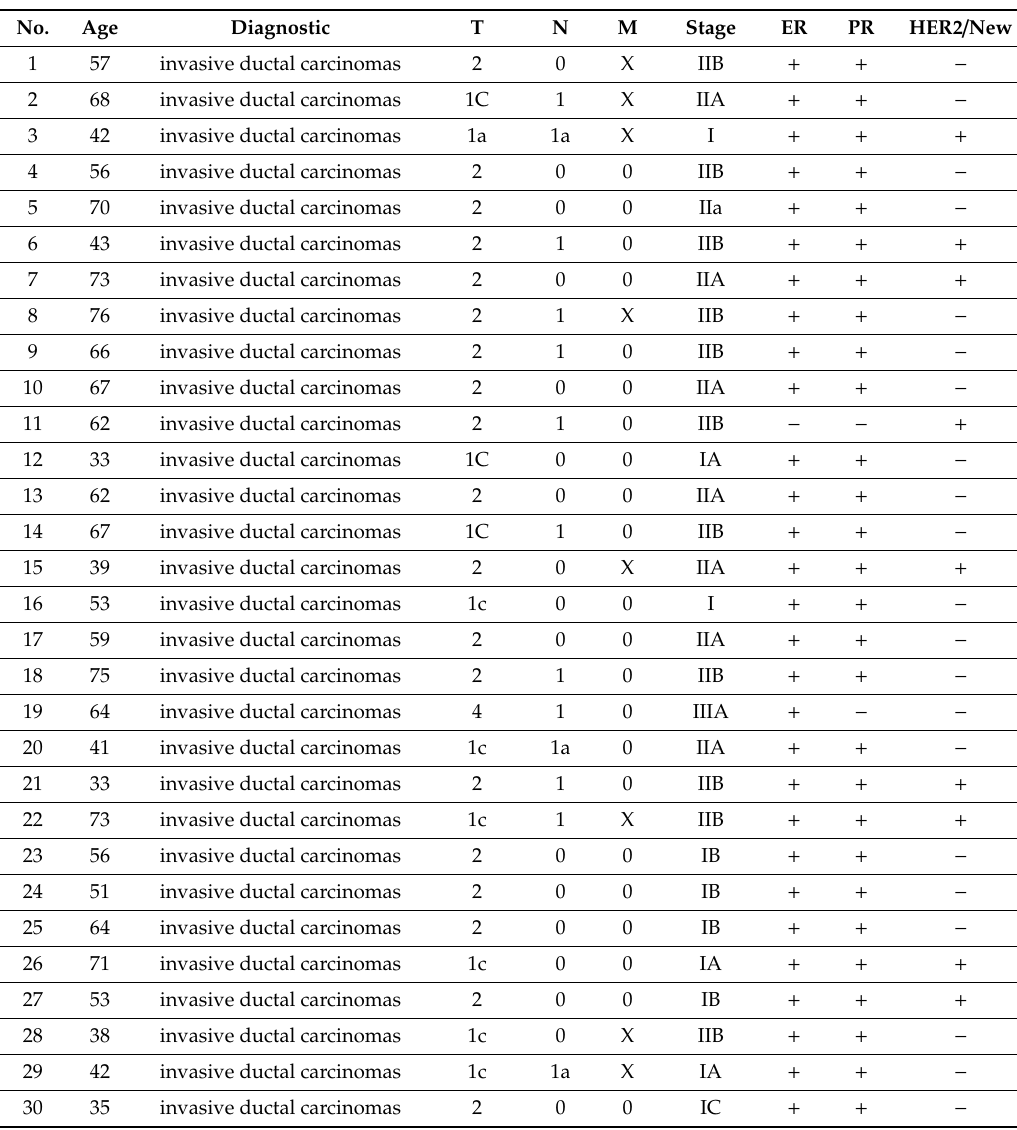
Table 2. Clinical characteristics of breast patients included in this study (T: tumor, N: lymph nodes, and M: metastasis). ER: estrogen receptor, PR: progesterone receptor, and HER2: human epidermal growth factor receptor